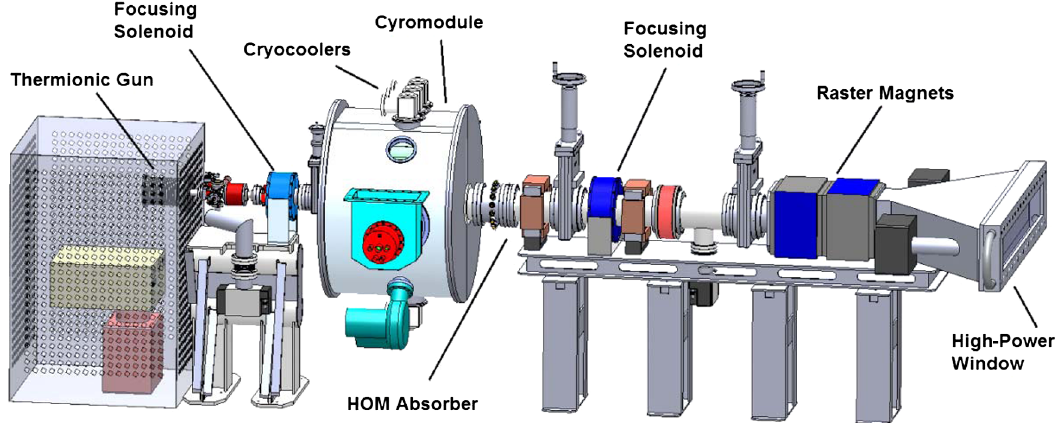
FIG. 1. Schematic layout of the 1 MeV, 1 MW, cw SRF electron accelerator for wastewater and flue gas treatment. The estimated overall length of the accelerator is 6